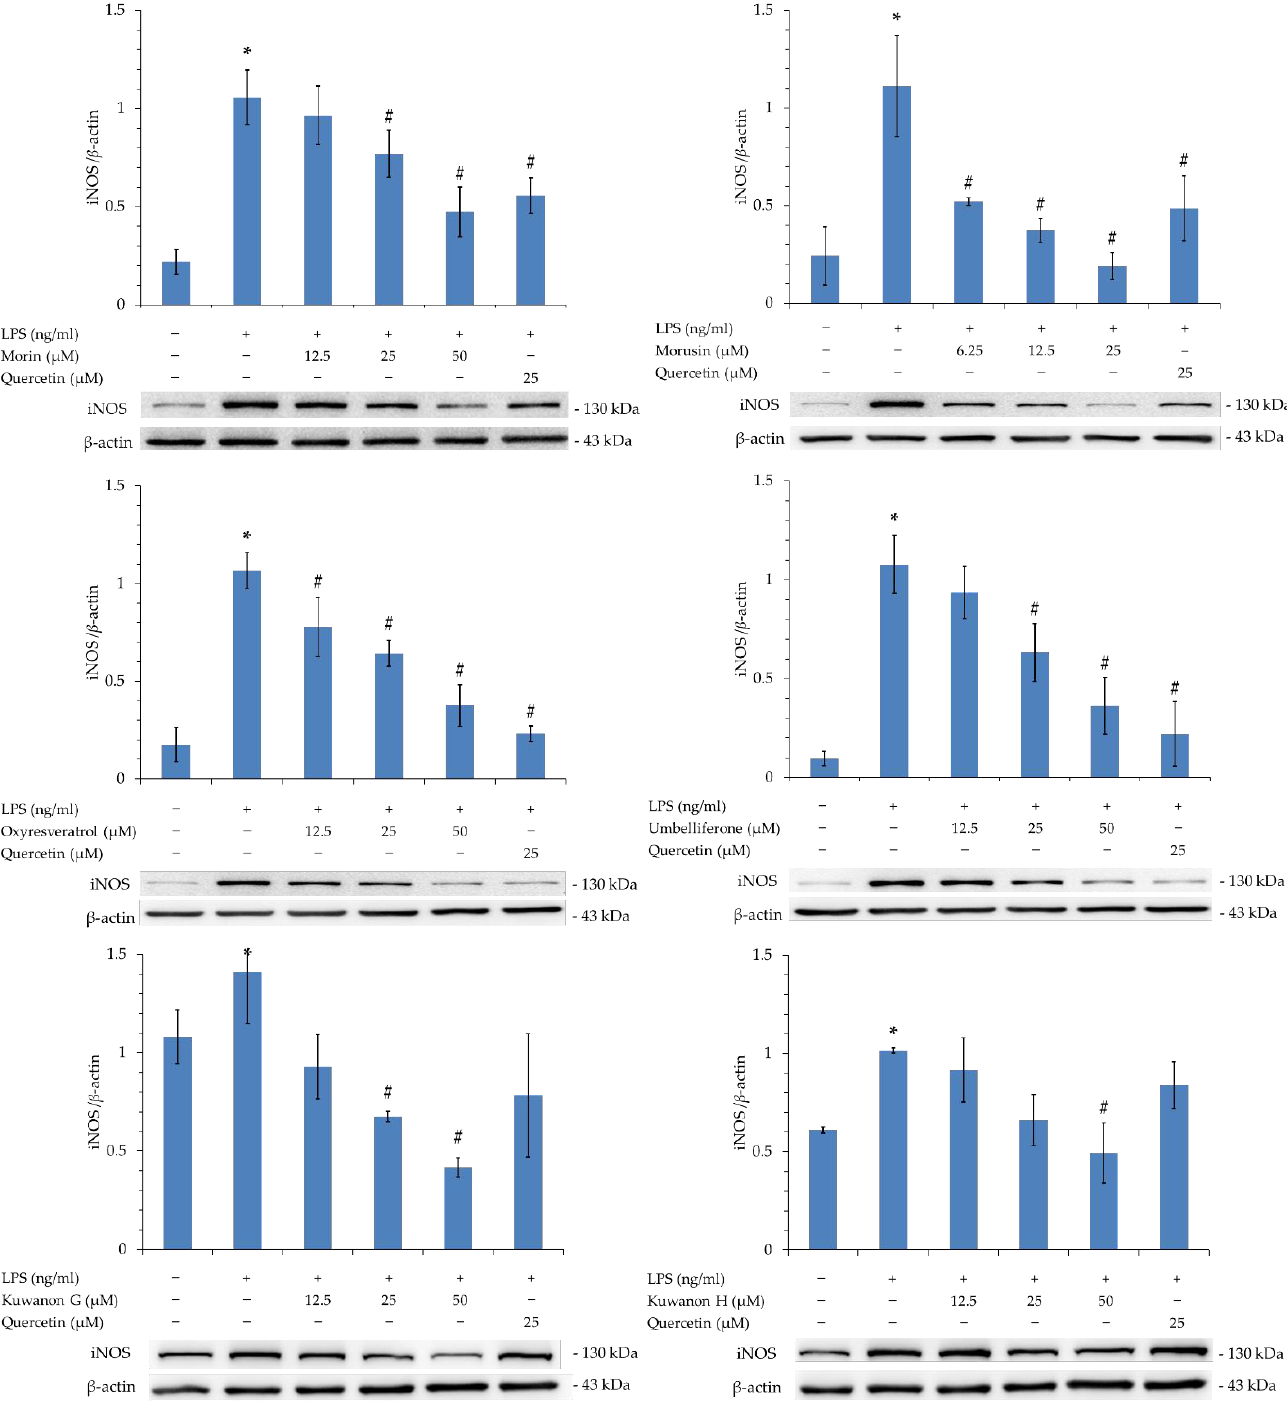
Figure 4. The isolated components were analyzed for iNOS expression by Western blotting. iNOS/ β - actin quantification data are expressed as mean ± SEM; quercetin was used as a positive control; * p < 0.05 compared to the control group, # p < 0.05 compared to the LPS group.